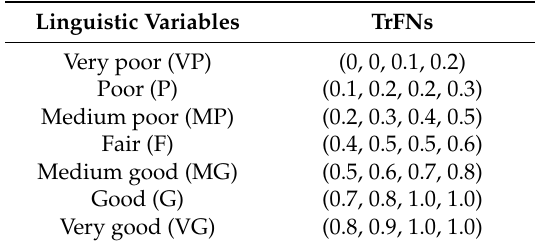
Table 2. Linguistic terms and TrFN numbers comparison.